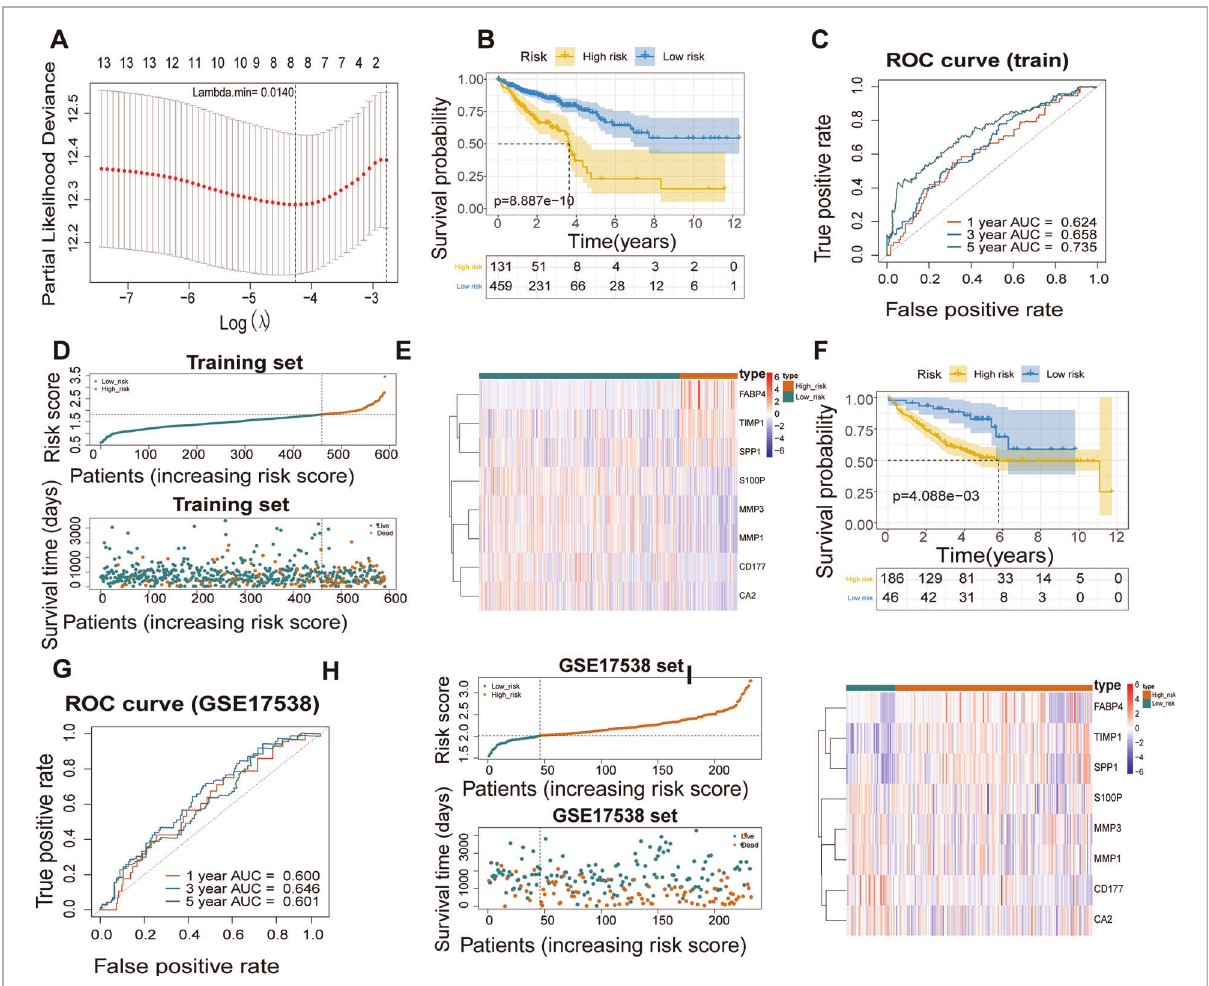
FIGURE 2 Establishment of a UC- relevant risk score model. ( A ) Least absolute shrinkage and selection operator (LASSO) regression analysis to establish an eight-gene signature. ( B ) Kaplan – Meier curves of the high- and low-risk groups in TCGA-CRC dataset. ( C ) Receiver operating characteristic (ROC) curves of 1, 3, and 5 years overall survival (OS) in TCGA-CRC dataset. ( D ) Signature-based distribution of risk scores and survival status in TCGA-CRC dataset. ( E ) Differences in prognostic gene expression in different risk groups in TCGA-CRC dataset. ( F ) Kaplan – Meier Curve of the high- and low-risk groups in GSE17538 dataset. ( G ) ROC curves of 1, 3, and 5 years OS in GSE17538 dataset. ( H ) Distribution of risk scores and survival status in GSE17538 dataset. ( I ) Differences in prognostic gene expression in different risk groups in GSE17538 dataset.